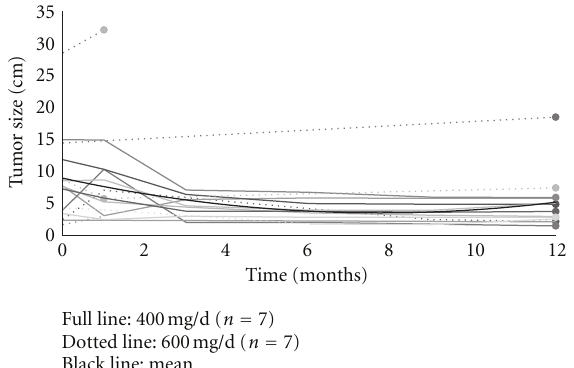
Figure 1: Tumour size evolution for each patient compared to mean tumour size (gray line) ( n = 14).